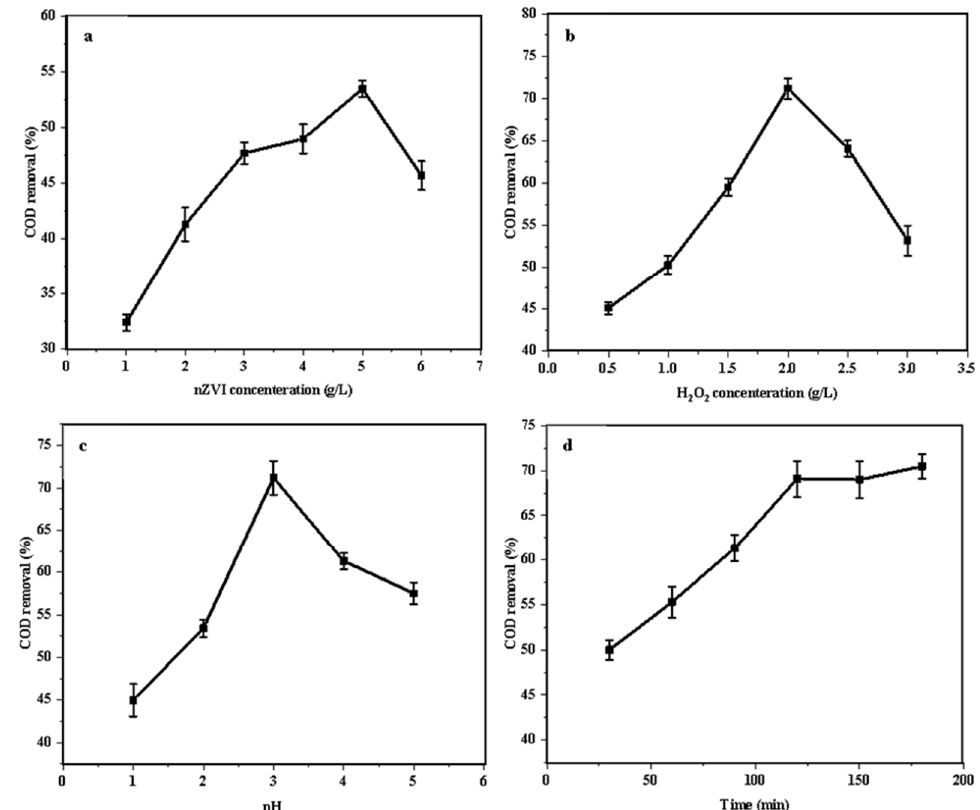
Figure 2. COD removal efficiencies at different concentrations of ( a ) nanoscale zero-valent iron (nZVI), ( b ) H 2 O 2 , ( c ) pH and ( d ) contact time.